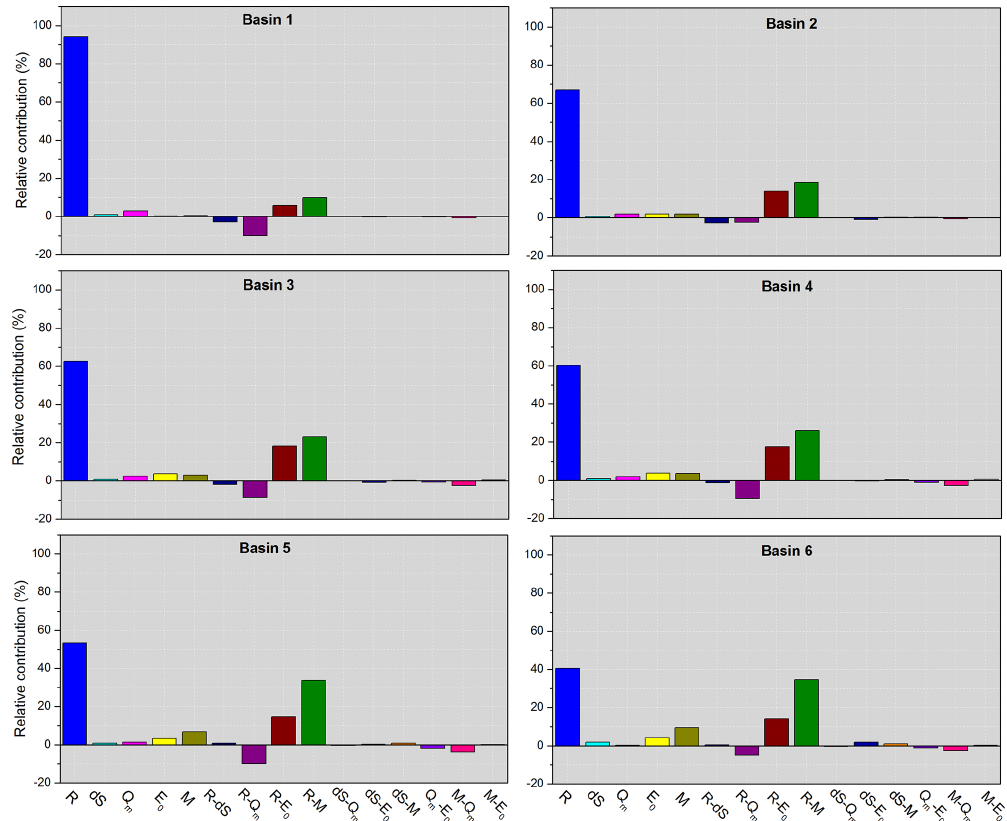
Figure 5. Contribution to the ET variance in the growing season from each component in Eq.